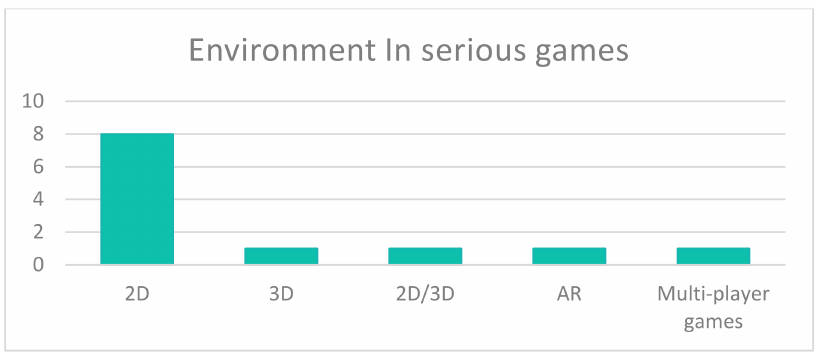
Figure 17. Environment in serious games.